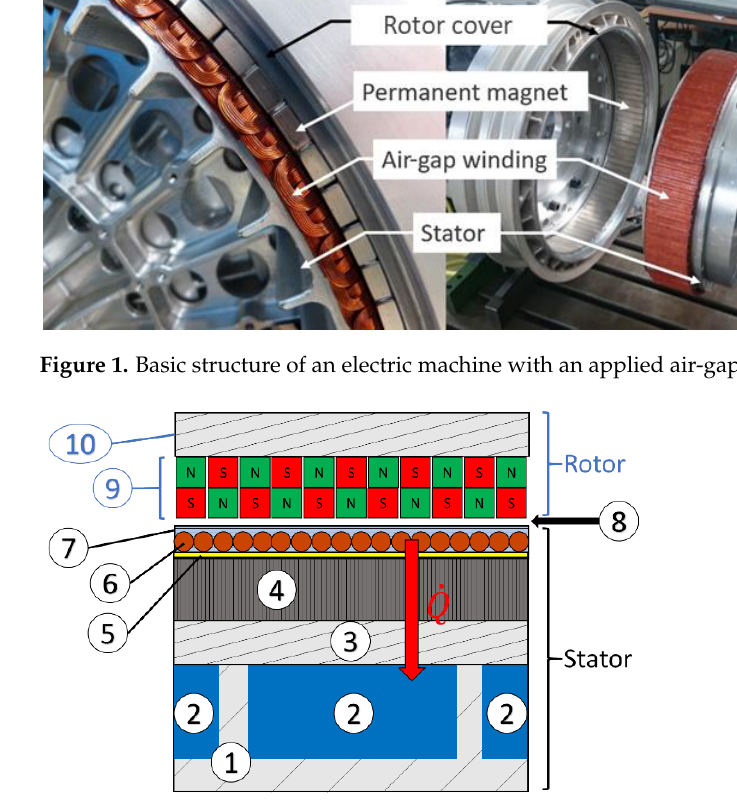
Figure 2. Structure of the stator and the inner rotor; visualization of the heat dissipation (1—stator base body, 2—cooling channels, 3—cover ring, 4—laminated iron core, 5—TIM, 6—winding, 7— bandage of glass fiber and resin, 8—air-gap, 9—permanent magnets, 10—rotor cover).